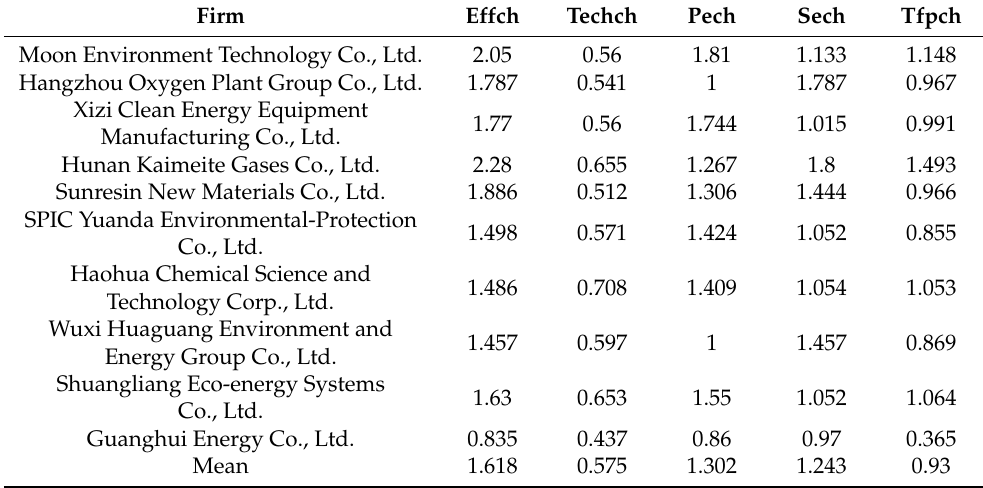
Table 8. Malmquist Index of Enterprise Technology Innovation and Its Decomposition